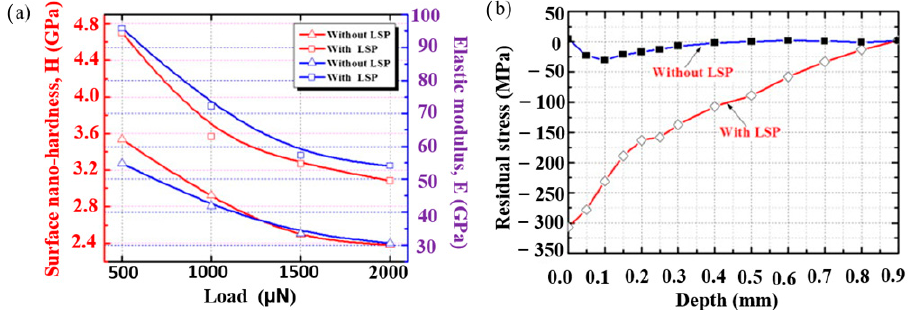
Figure 12. LSP on ANSI 304 SS and variation of ( a ) nano hardness and elastic moduli ( b ) residual stress with and without LSP. Reproduced with permission from [27]. Copyright Elsevier, 2011.